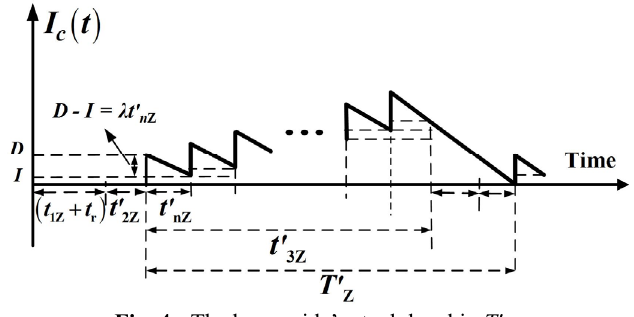
Fig. 4. The buyer side’s stock level in T' Z